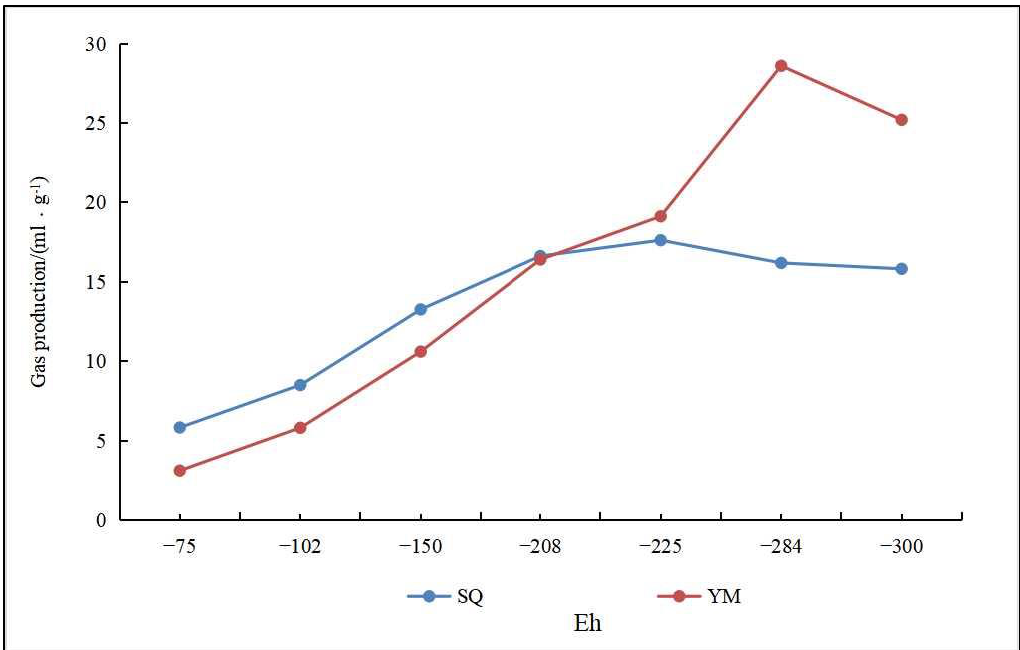
Figure 5. The relationship between Eh and gas production (Adapted from [106,107]). (The coal samples of ShaQu coal mines and YiMa coal mines are abbreviated as SQ and YM, respectively, in Figure).